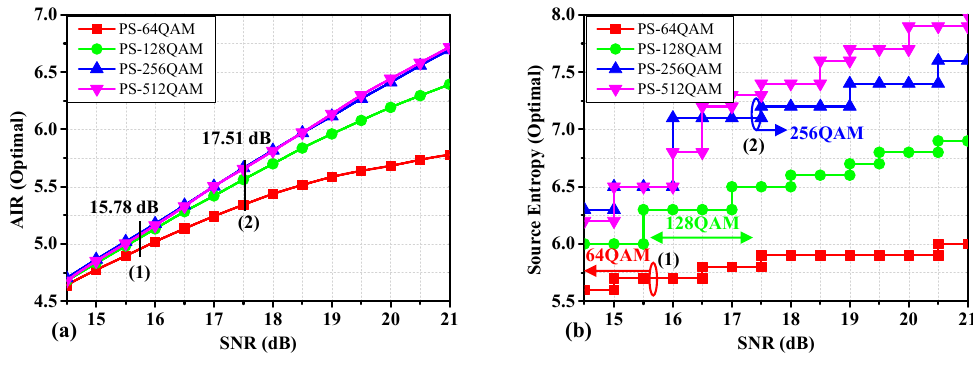
Figure 5. The AIR, SE and GMI performance with adaptive FEC code rate. ( a ) HAIR performance. ( b ) Corresponding SE of HAIR.